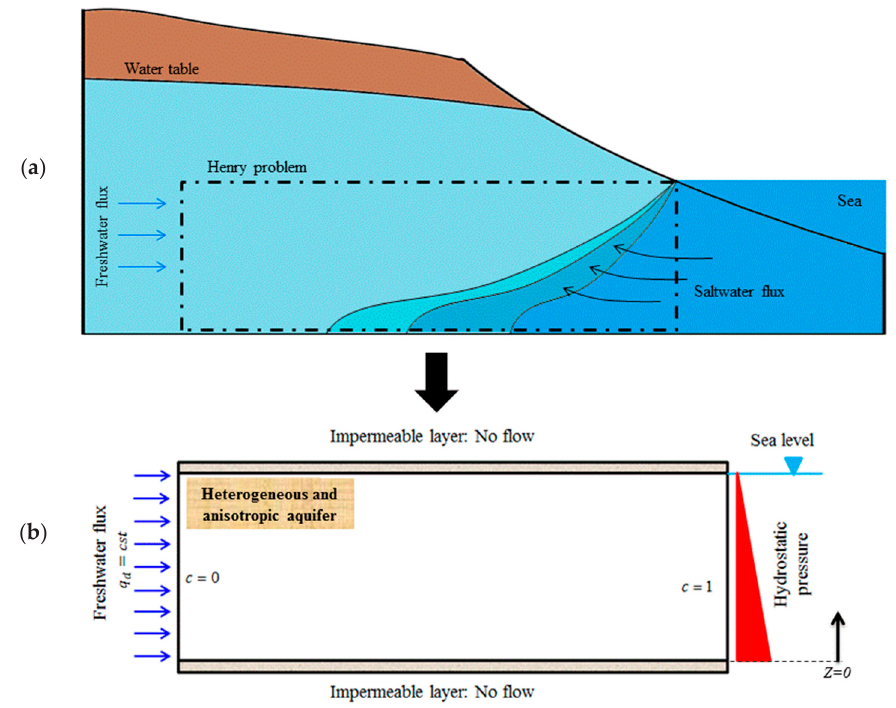
Figure 1. The Henry problem (HP) assumptions ( a ) real configuration and ( b ) conceptual model [3].